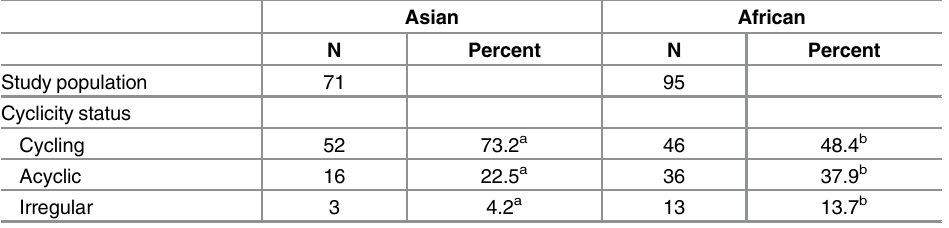
Average prolactin concentrations were three times higher in African than Asian elephants, due to the high percentage (28%) of Africans with consistently High prolactin indicating hyperpro- lactinemia (P < 0.05) (Table 3). Even within the Low/Normal prolactin groups, concentrations were higher in African females because of previously characterized cyclic dynamics of prolactin secretion; i.e., increased during the follicular phase in African, but not in Asian elephants [10,19]. Prolactin levels were related to cyclicity status in African females (Table 4), with con- centrations being higher in acyclic (24.02 ± 4.82 ng/ml) than cycling (10.75 ± 0.73 ng/ml) females, and in between for irregular cycling females (21.50 ± 2.34 ng/ml). While 44% (41/93) of African elephants with Low/Normal prolactin levels were cycling, only 12% (3/26) of African elephants with High prolactin levels were cycling normally. These three differed from acyclic Table 2. Ovarian cyclicity status for female Asian and African elephants in the AZA